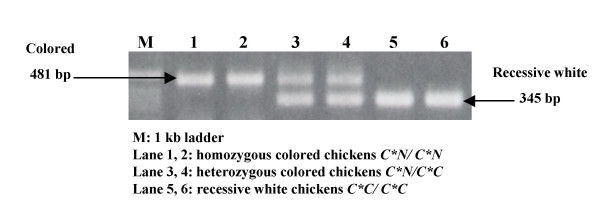
Diagnostic genotyping test result. Only one band either 481 bp or 345 bp was found in homozygous colored or homozygous recessive white chickens, respectively. In heterozygous chickens, both 481 bp and 345 bp bands were detected by the diagnostic genotyping test.